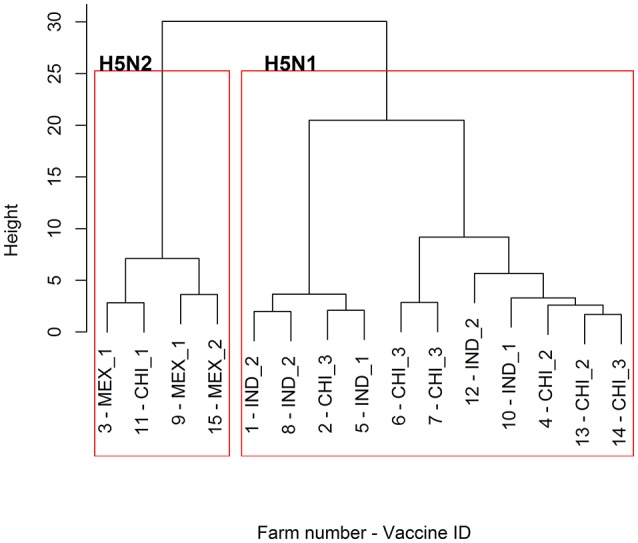
Dendrogram of the hierarchical cluster analysis of the HI profiles of the 15 sampled farms. For the provenance of the vaccines used for the POL vaccination on each of the farms, refer to Table 2.